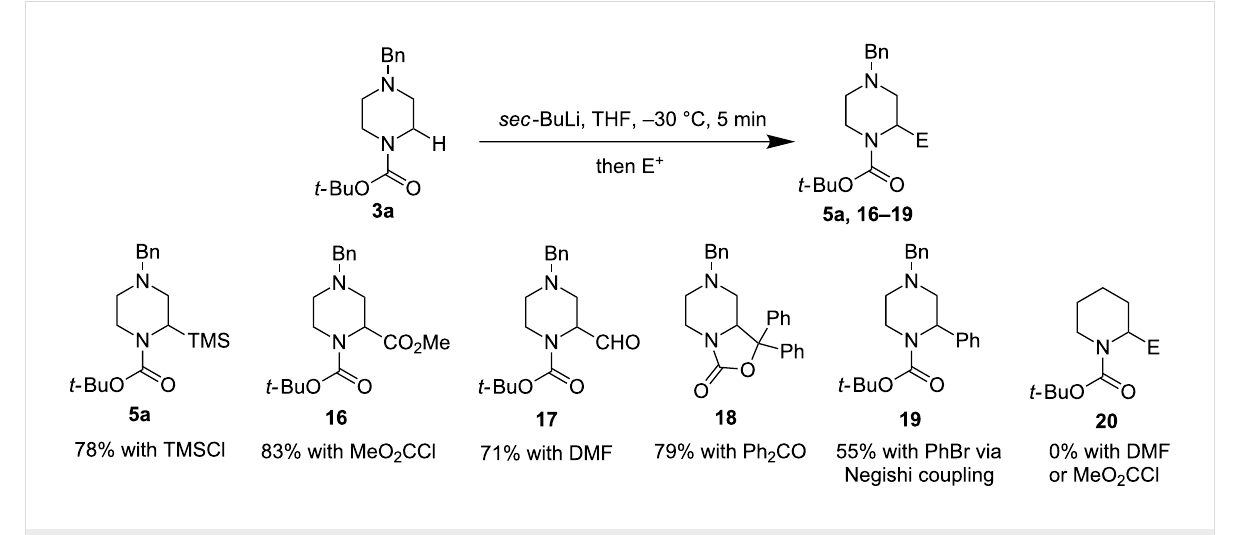
Figure 5: Diamine-free α -lithiation of N -Boc-piperazines by O’Brien, Campos, et al. in 2010 [40].